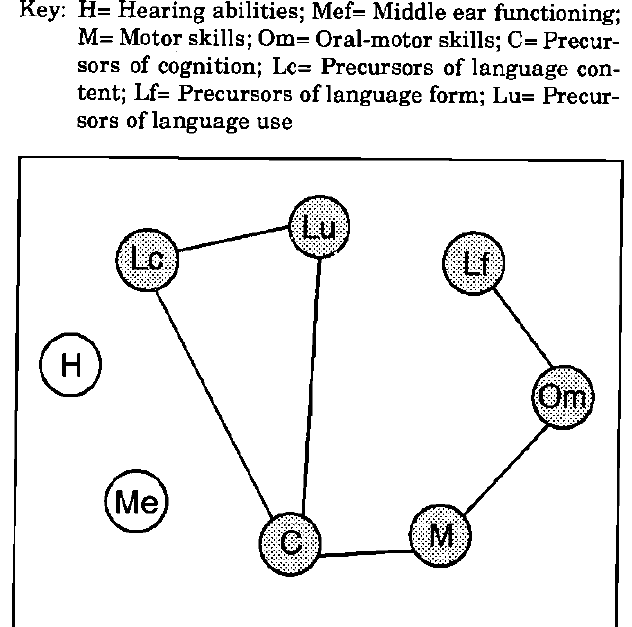
Figure III: Significant correlations between the re- sults of the different developmental areas, N=50 Key: H= Hearing abilities; Me= Middle ear functioning; M= Motor skills; Om= Oral-motor skills; C= Precur- sors of cognition; Lc= Precursors of language con- tent; Lf= Precursors of language form; Lu= Precur- sors of language